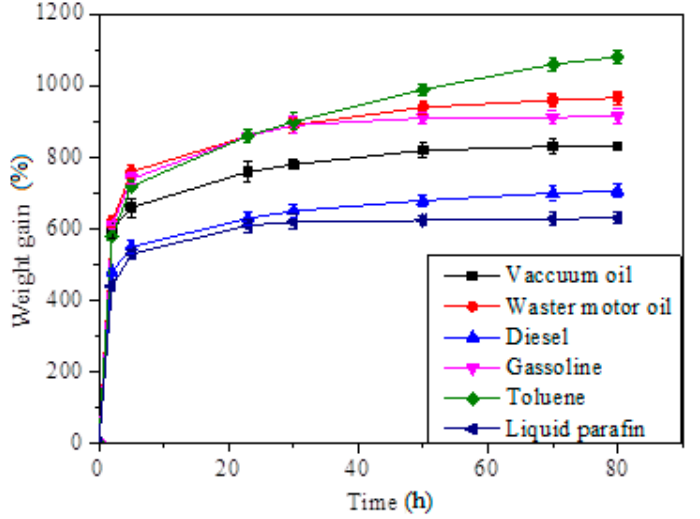
Figure 10. Absorption kinetics of oils and organic solvents on the silane-coated cellulose aerogel.